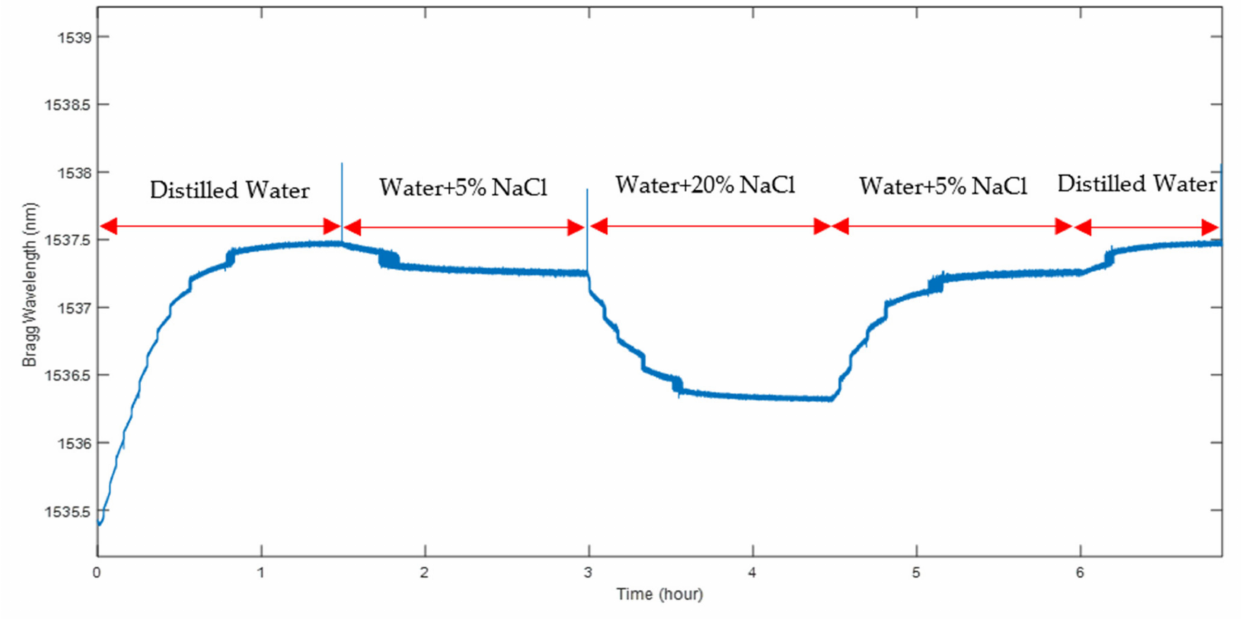
Figure 12. PMMA-based sensor assessment for reversible process in different NaCl